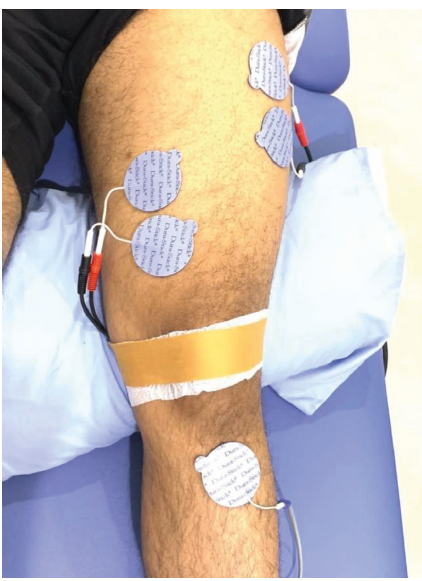
Figure 4: Placements of surface electrodes for electromyographic biofeedback.